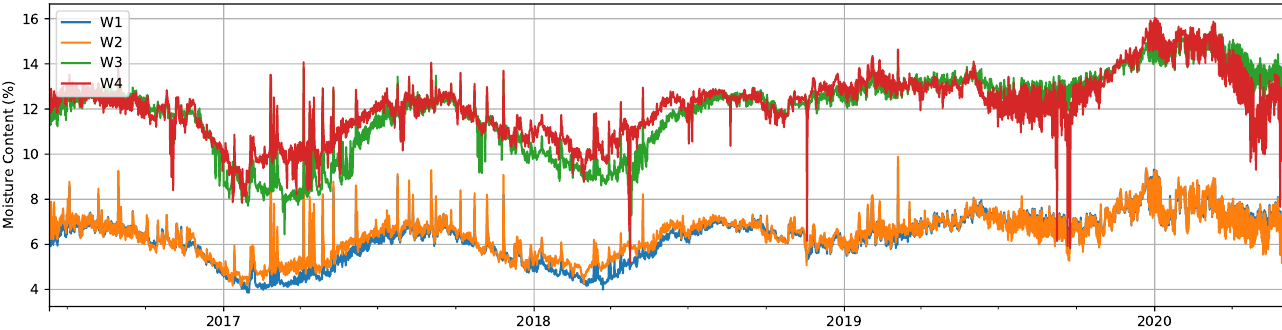
Figure 7. Computed moisture content (%) for measurements from the